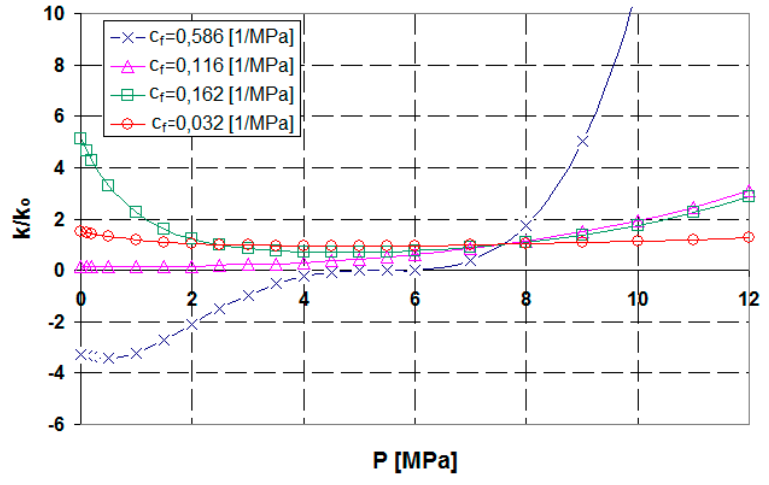
Figure 1. Changes in permeability in relation to changes in the methane pressure based on the Palmer and Mansoori model [1,2].